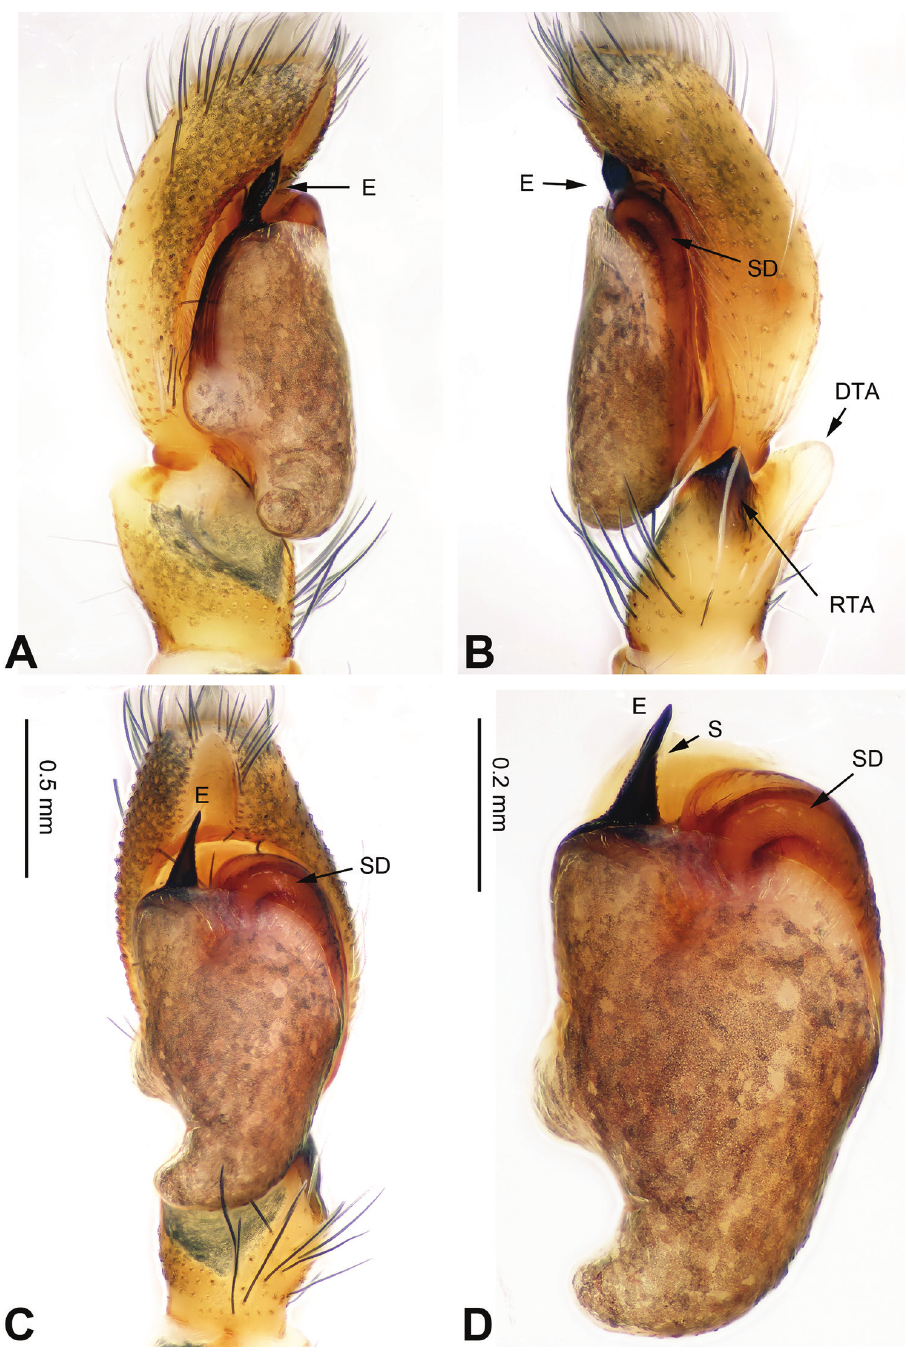
Figure 5. Palp of Bavia capistrata , male from Xishuangbanna. A prolateral B retrolateral C ventral D bulb, ventral. Scale bar equal for A–C